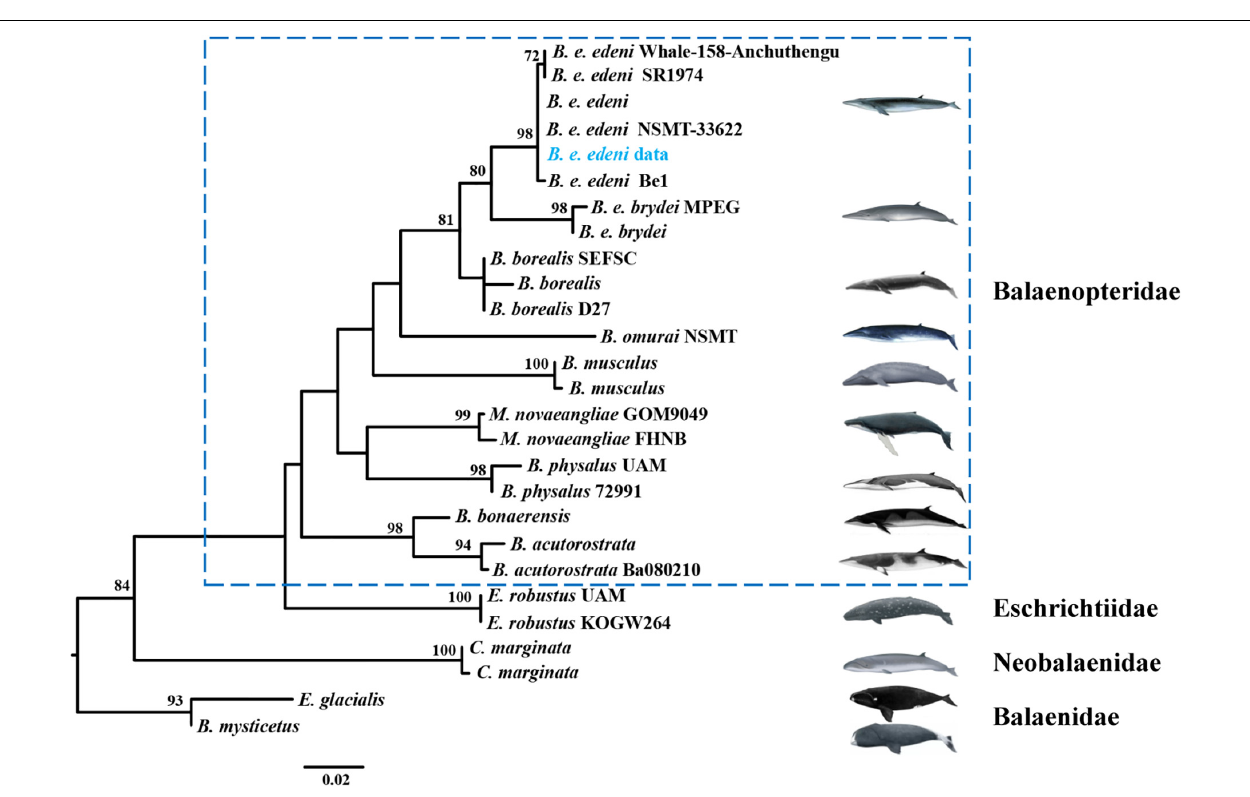
Frontiers in Ecology and Evolution |